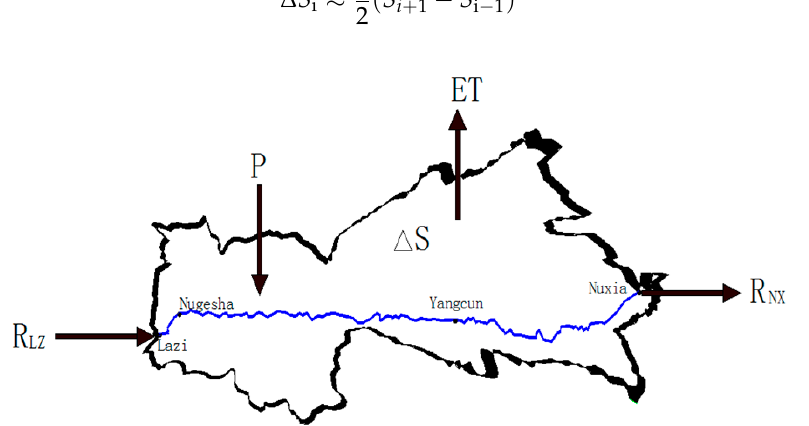
Figure 2. A Schematic Diagram for the Water Balance Equation.